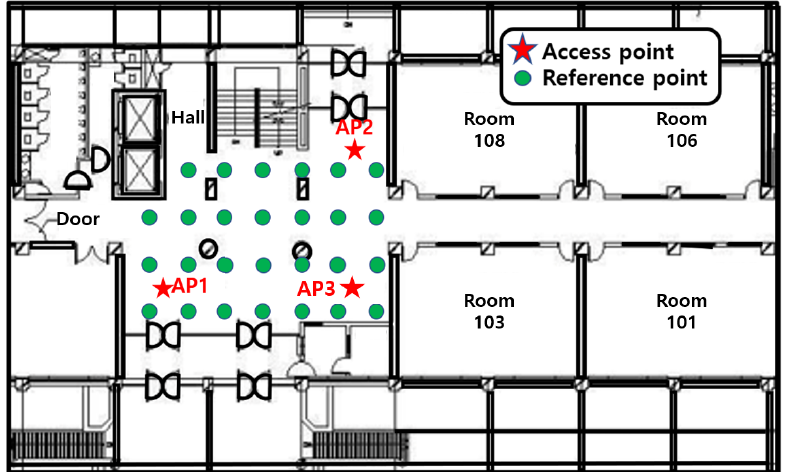
Figure 21. Floor plan of the lobby on the 1st floor of KNU IT-2